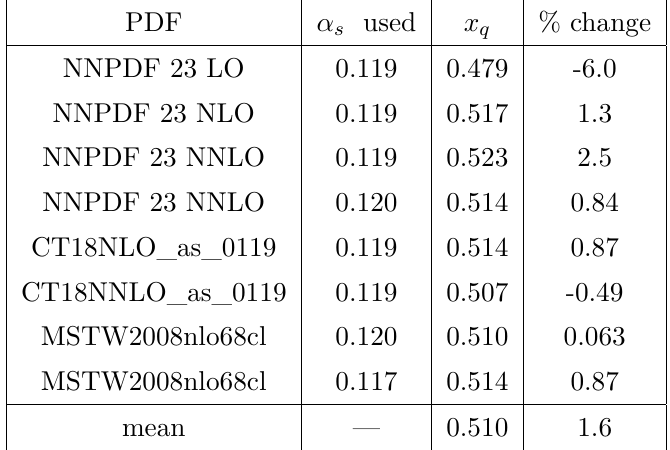
— 0.510 1.6 Table 1 . Quark/Gluon fraction for different parton distribution functions which average to x q = 0 . 510 with a standard deviation of 0 . 013 . The % changes are listed relative to this mean and the average % change is the average of the absolute value of these %’s. These PDF sets were chosen fairly arbitrarily as a roughly representative sample, including some with the same value of α and s different orders. This rough estimate indicates uncertainty on α stemming from the quark/gluon s fraction and associated PDF choice is subdominant to other sources of theoretical uncertainty at the current